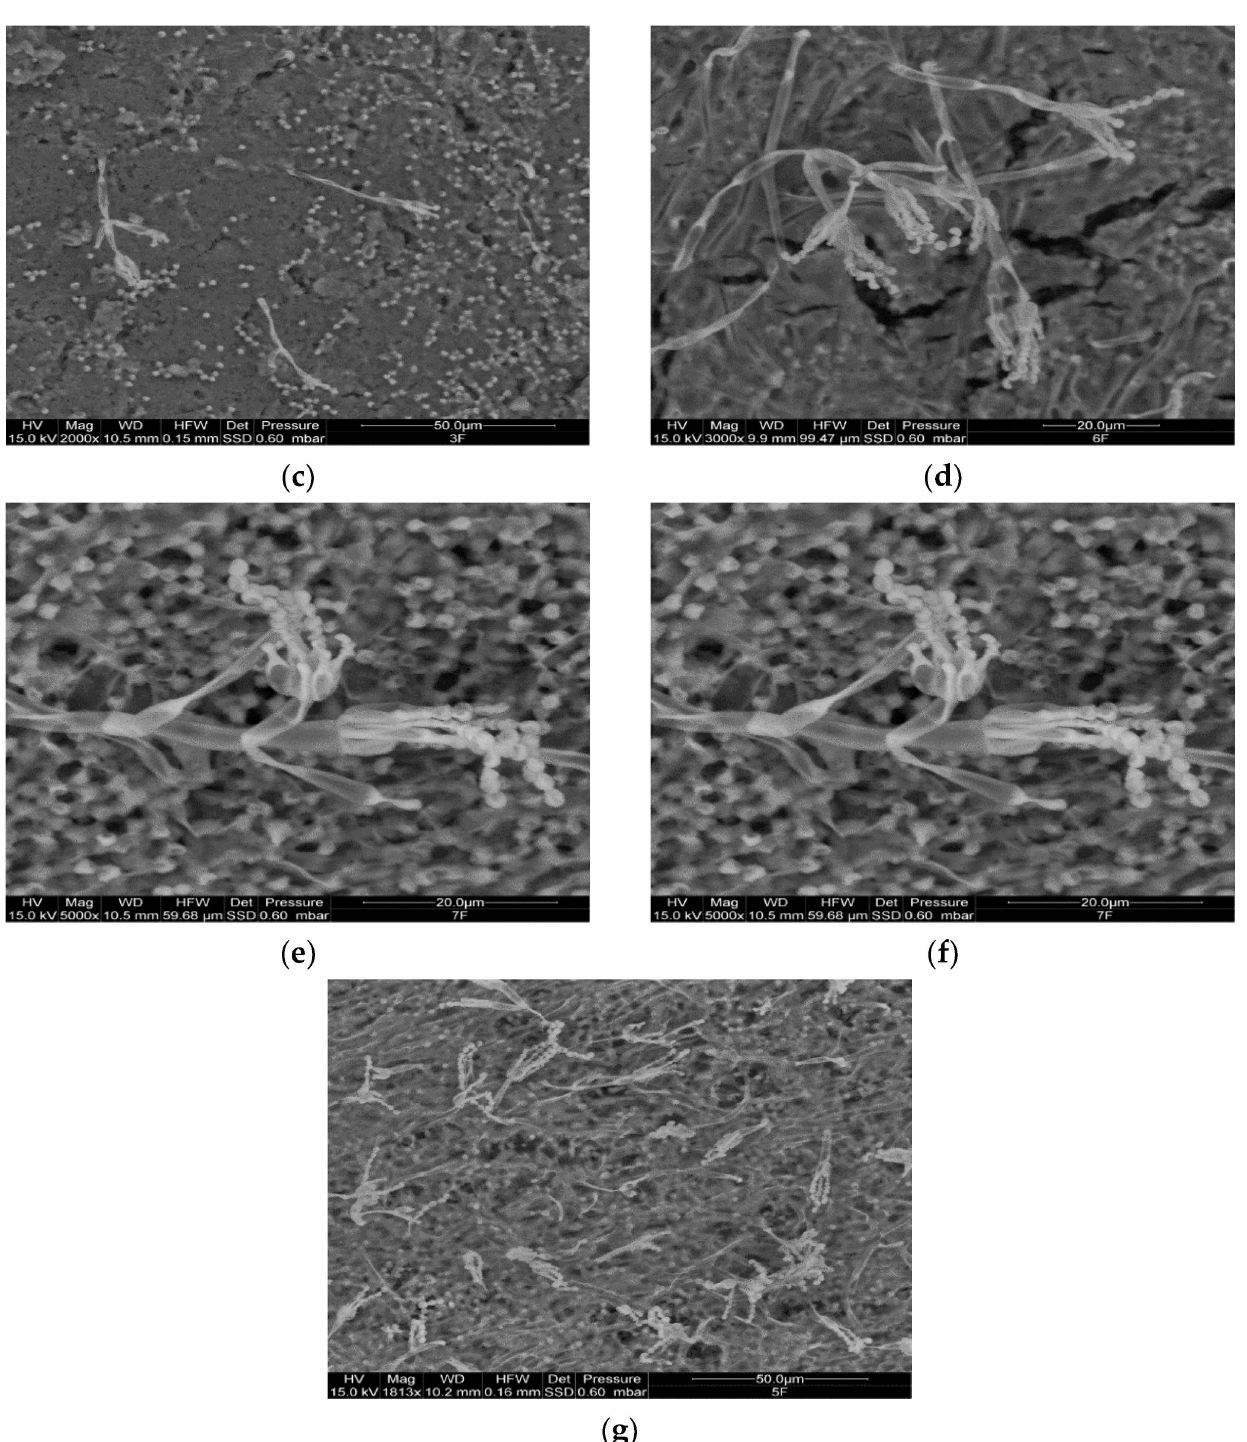
Figure 3. Representative ESEM images of the different resins with fungal growth recovered after 7 days of incubation: ( a ) AC 012 and ( b ) AC 013 presenting conidia and hyphae of P. citrinum LS1; ( c ) PU H6 with conidia, as well as conidiophores of P. citrinum LS1; ( d ) AC P1 with conidia and conidiophores of P. citrinum LS1; ( e ) AC 32 showing spores and hypae of P. citrinum LS1; ( f ) PU GS with contemporary presence of spores and hypae of P. citrinum LS1 and blastoconidia of A. pullulans ATCC 15233; ( g ) PU MW2 presenting conidia and conidiophores of P. citrinum